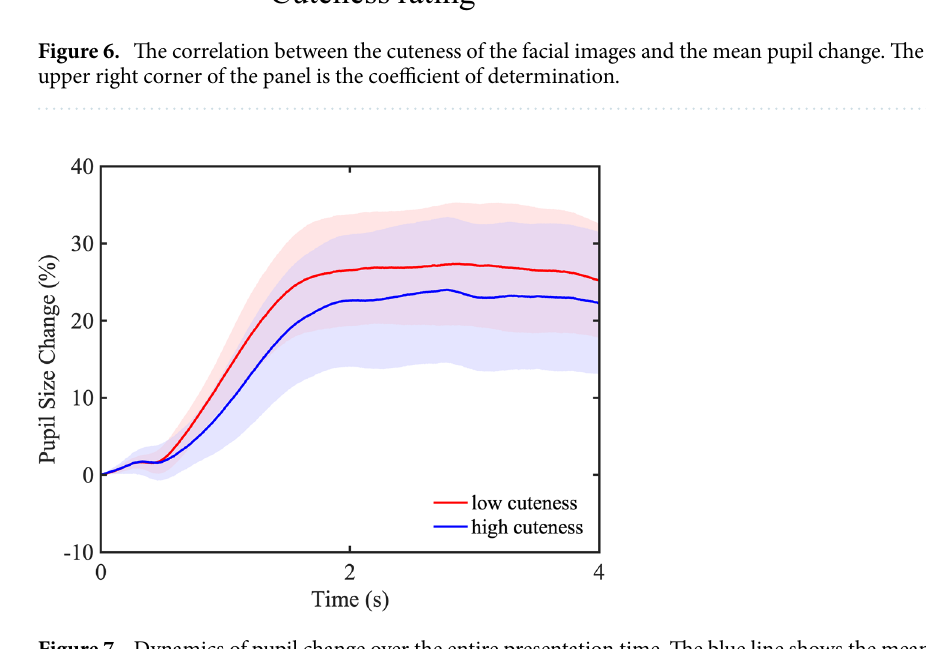
Figure 7. Dynamics of pupil change over the entire presentation time. The blue line shows the mean pupil change of the 12 images with a high cuteness rating, and the red line shows the mean pupil change of the 12 images with a low cuteness rating. The blue-colored area indicates a 95% confidence interval for the images with high cuteness rating, and the red-colored area indicates a 95% confidence interval for the images with low cuteness